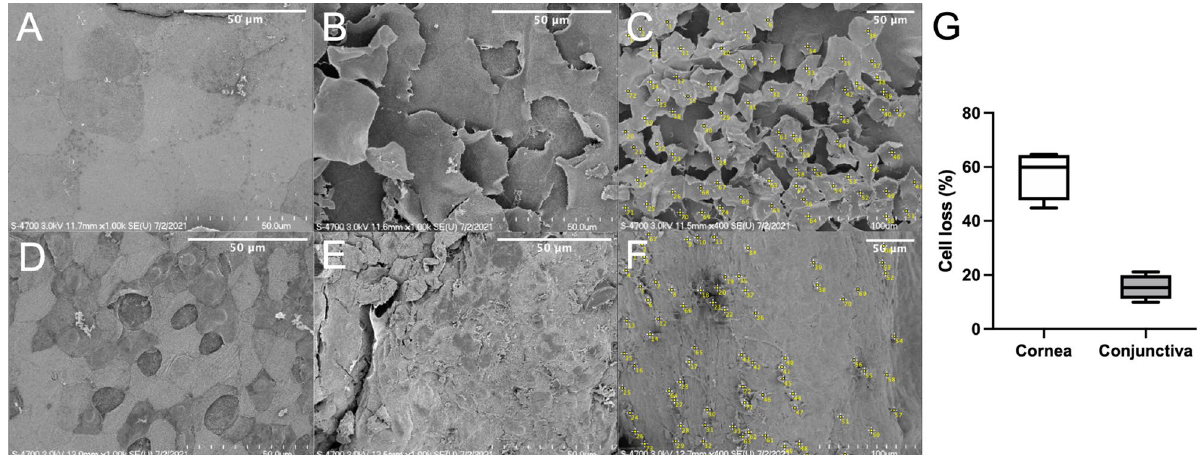
Figure 4. Comparison of changes in the corneal ( A – C ) and conjunctival ( D – F ) epithelium as observed by scanning electron microscopy in the control ( A , D ) and exposure rabbit model 30 min after exposure ( B , C , E , F ). Percentage of cell loss, which shows epithelial cell sloughing or morphologic change was significantly higher in cornea than conjunctiva ( C , F , G ). Bar: 50